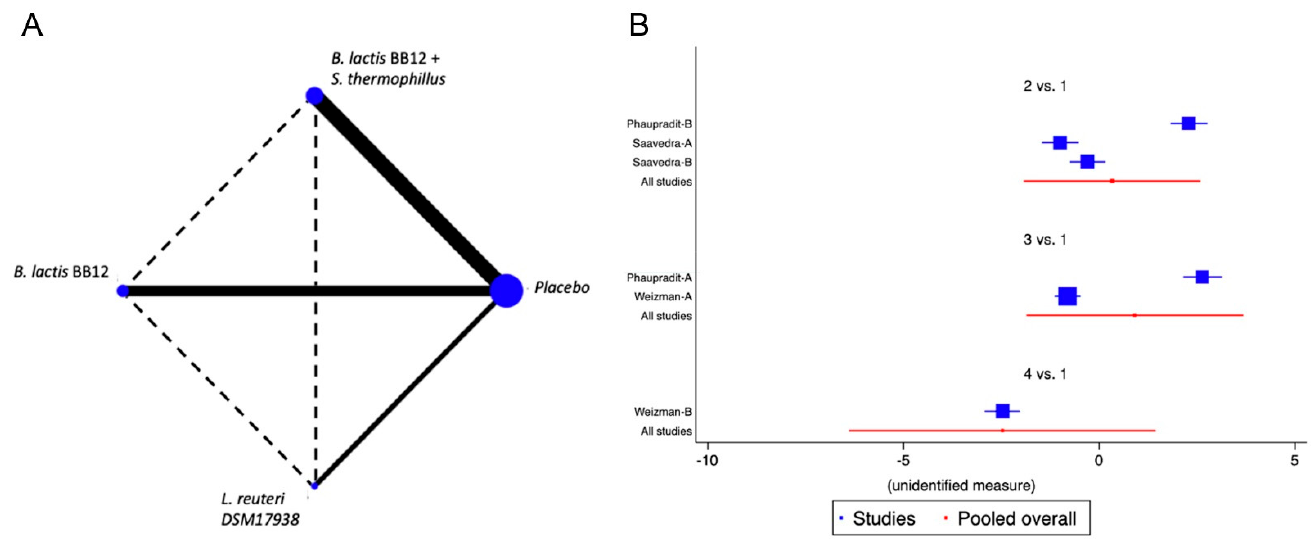
Figure 3. Network Meta-Analysis for probiotics in infant formula and diarrhoea. ( A ) Network diagram: the area of the blue nodes is based on the total number of patients for each respective interventions, the thickness of continuous lines represents the total number of studies comparing treatments/nodes vs placebo, dashed lines represent comparisons between two active interventions; ( B ) forest plot of multiple treatments.